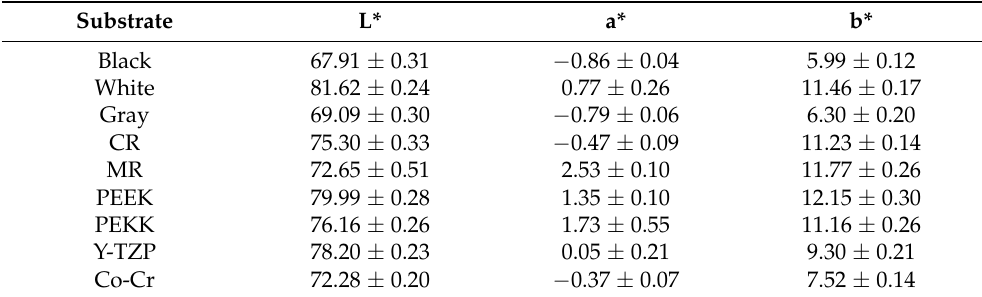
Table 3. Mean ± standard deviations (SD) for the color attributes (L*, a*, and b*) of M-Zr samples on different substrates (n = 3).